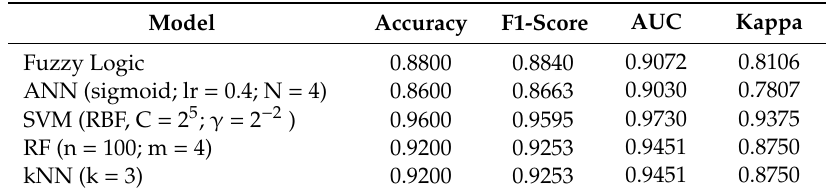
Table 5. Evaluation metrics (accuracy, F1-score, Area Under the Curve (AUC), Kappa) for each model. ANN = Artificial Neural Networks; SVM = Support Vector Machines; RF = Random Forests; kNN = k-Nearest Neighbor.